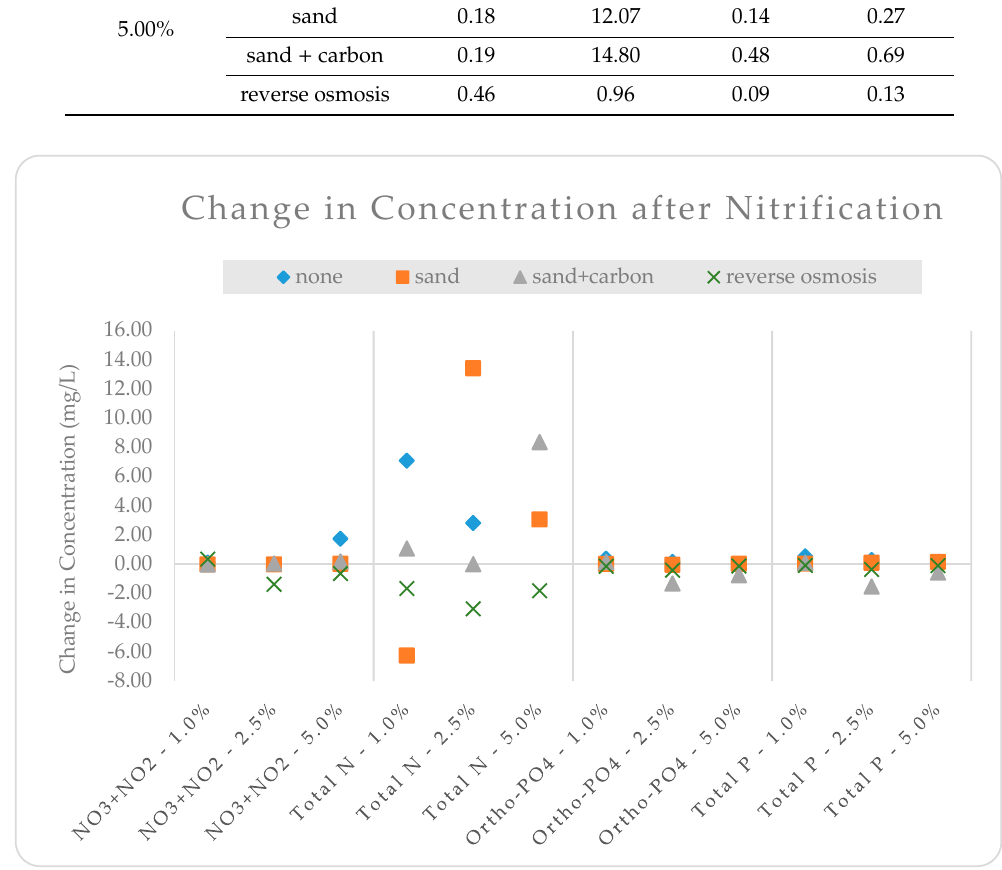
Figure 7. The change in concentration of each form of nitrogen and phosphorus after nitrification was induced from the four treatments.